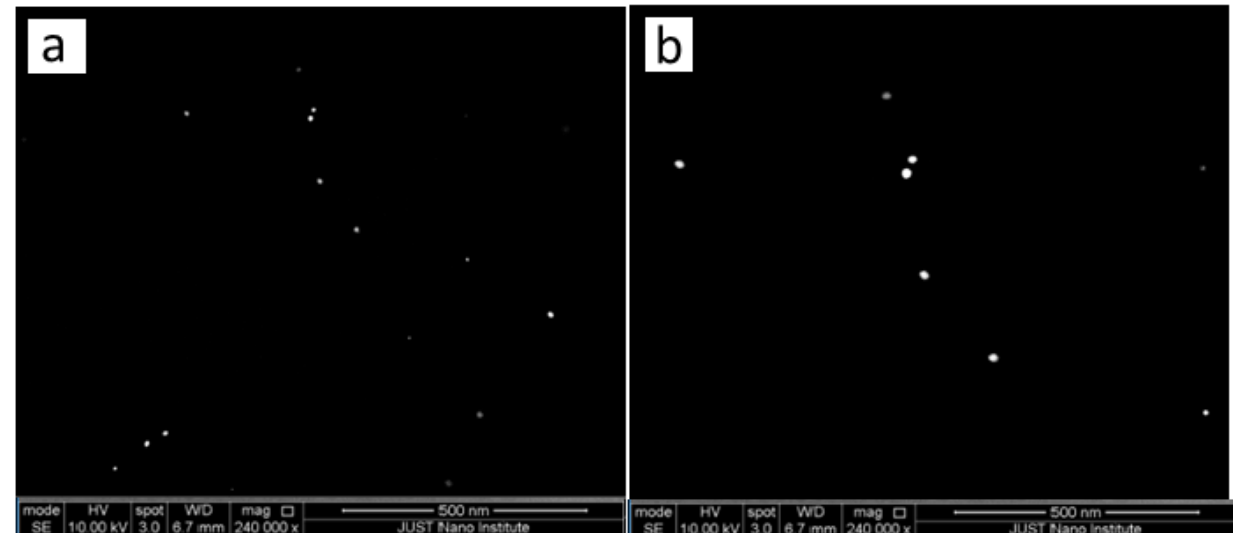
Figure 6. SEM images of the GNPs prepared at various HAuCl 4 Concentration. ( a ) at 0.1 mM, ( b ) at 2 mM. (After one day. Temperature = 308.15 K, total flowrate of SB and gold with SC = 1.66 × 10 −5 L/s, Volumetric ratio of SB/HAuCl 4 = 4:10, pH i = 3).